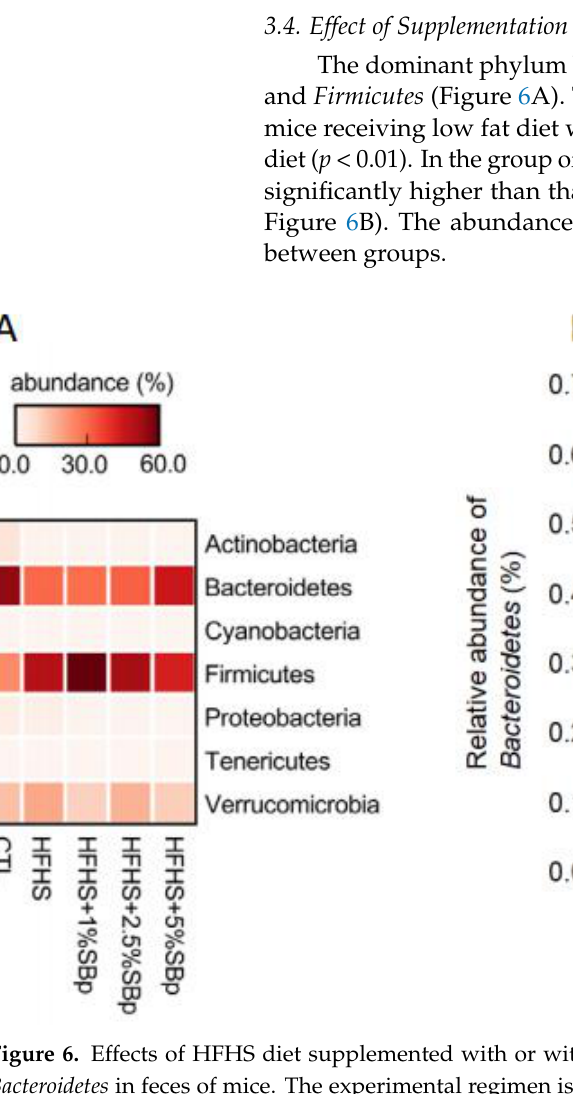
Figure 6. Effects of HFHS diet supplemented with or without SBp on the relative abundance of phylum bacteria and Bacteroidetes in feces of mice. The experimental regimen is described in the legend of Figure 4. ( A ) heat map of phylum bacteria; ( B ) relative abundances of Bacteroidetes . Values are expressed in median and range of Bacteroidetes ( n = 8/group). **: p < 0.01 vs. the control (CTL) group; + p < 0.01 vs. the HFHS group; ^^: p < 0.01 vs. 1% SBp; #: p < 0.05 vs. 2.5% SBp.